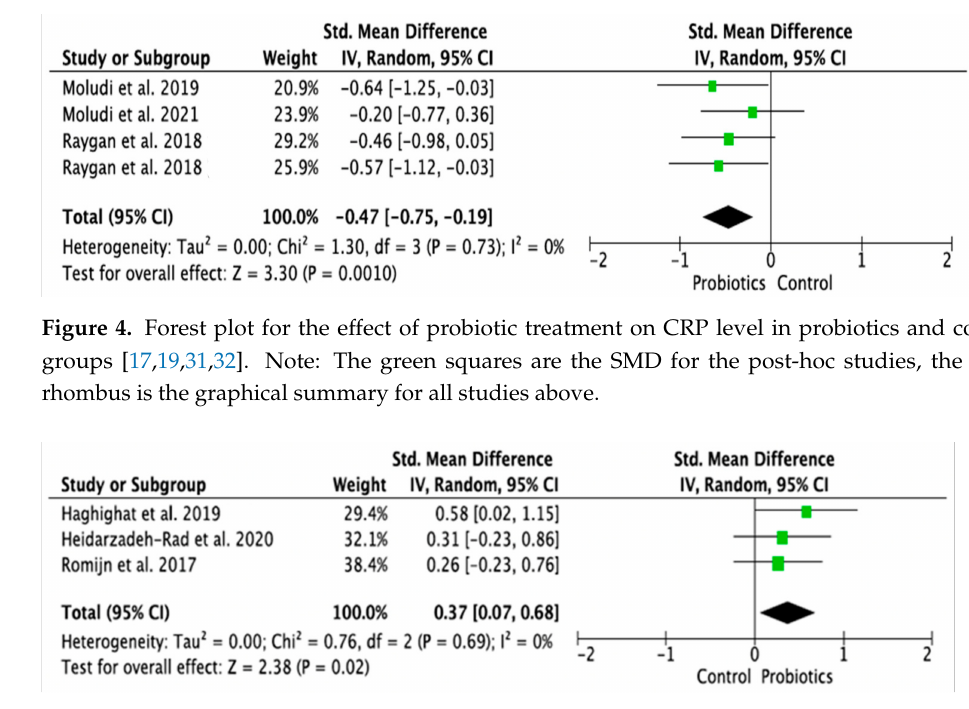
Figure 5. Forest plot for the effect of probiotic treatment on BDNF level in probiotics and control groups [20,23,30]. Note: The green squares are the SMD for the post-hoc studies, the black rhombus is the graphical summary for all studies above.